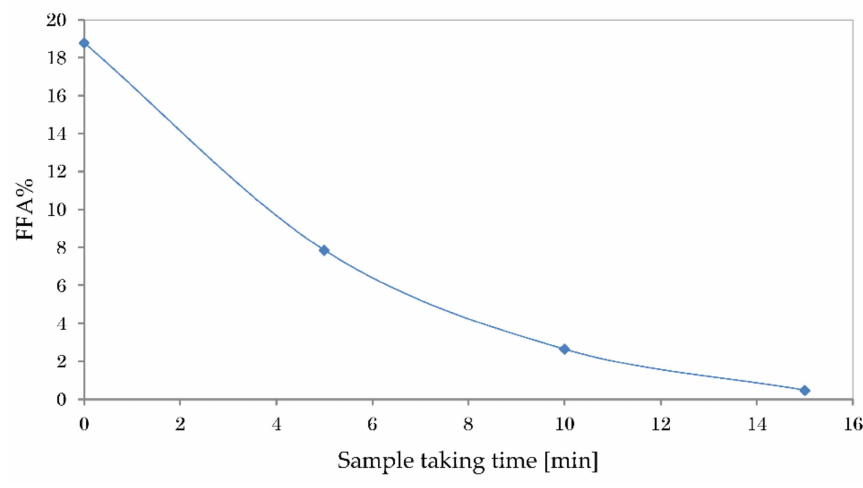
Figure 12. FFA variation during the glycerolysis reaction (Temperature: 200 ◦ C, Stirring speed: 350 rpm, Time: 2 h, Catalyst: 1 wt.% KOH, Co-solvent: 0.5 wt.% hexane, Oil-to-glycerol molar ratio: